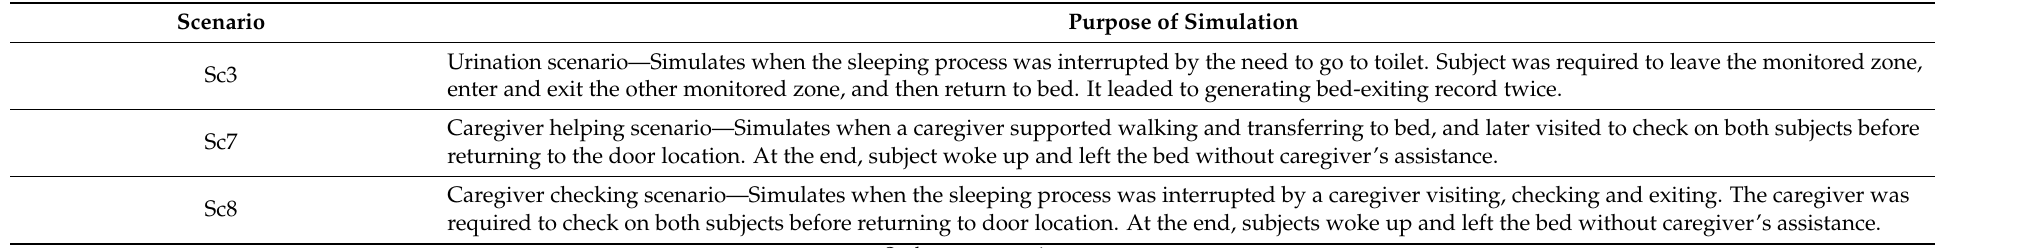
Table 4. Modified stimulated bed-time activity